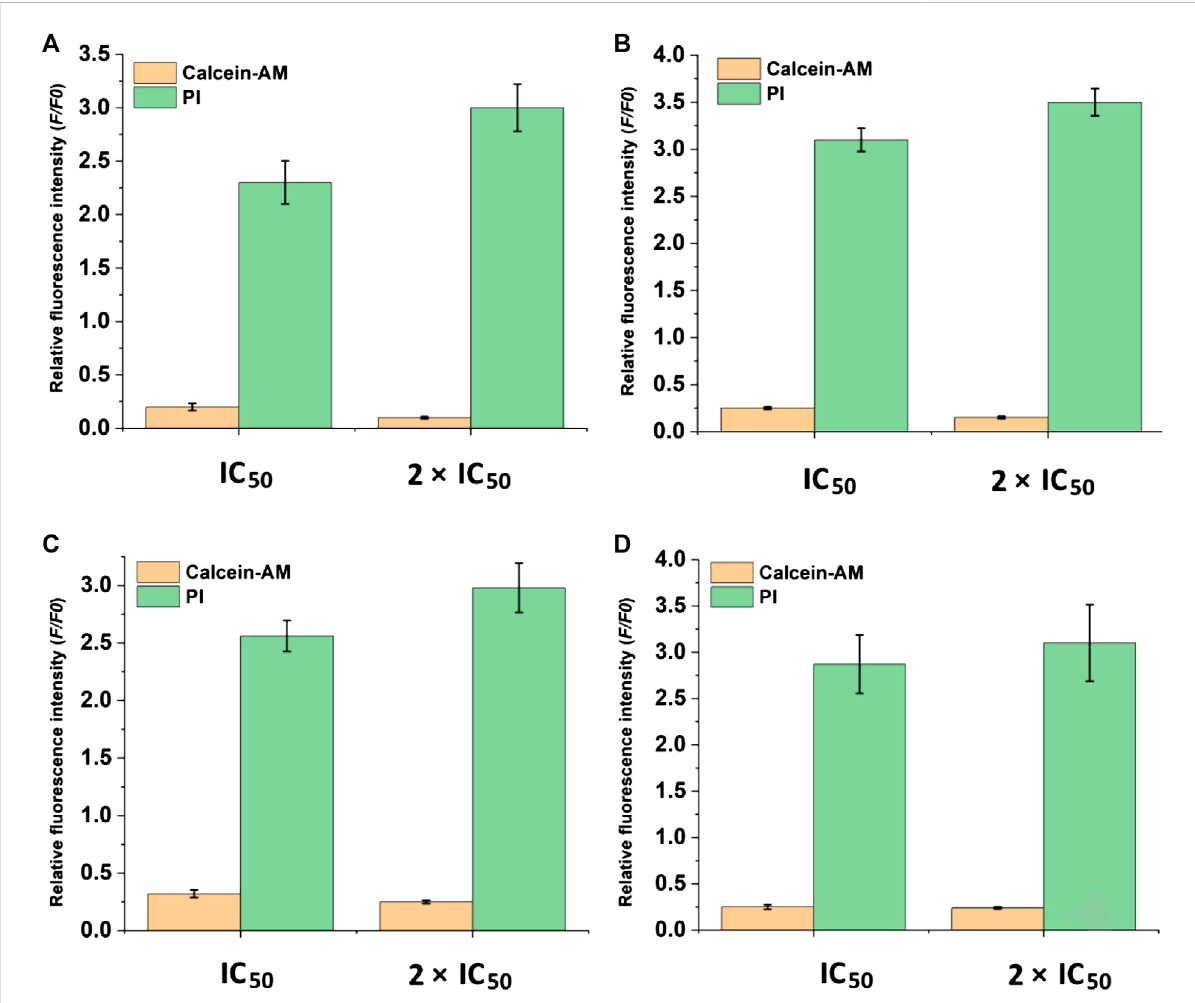
FIGURE 7 Quanti fi cationof fl uorescenceintensityofcalceinAMandPI-stainedcells. (A) HepG2cellsand (B) Huh7cellstreatedwithcompound 1 NPs. (C) HepG2 cells and (D) Huh7 cells treated with compound 2